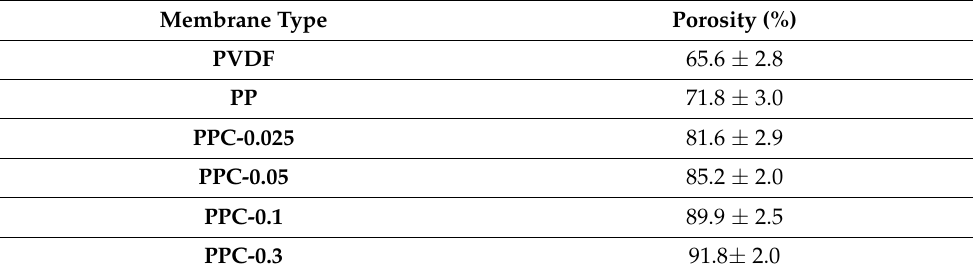
Table 4. Membranes’ top layer pore size and porosity.